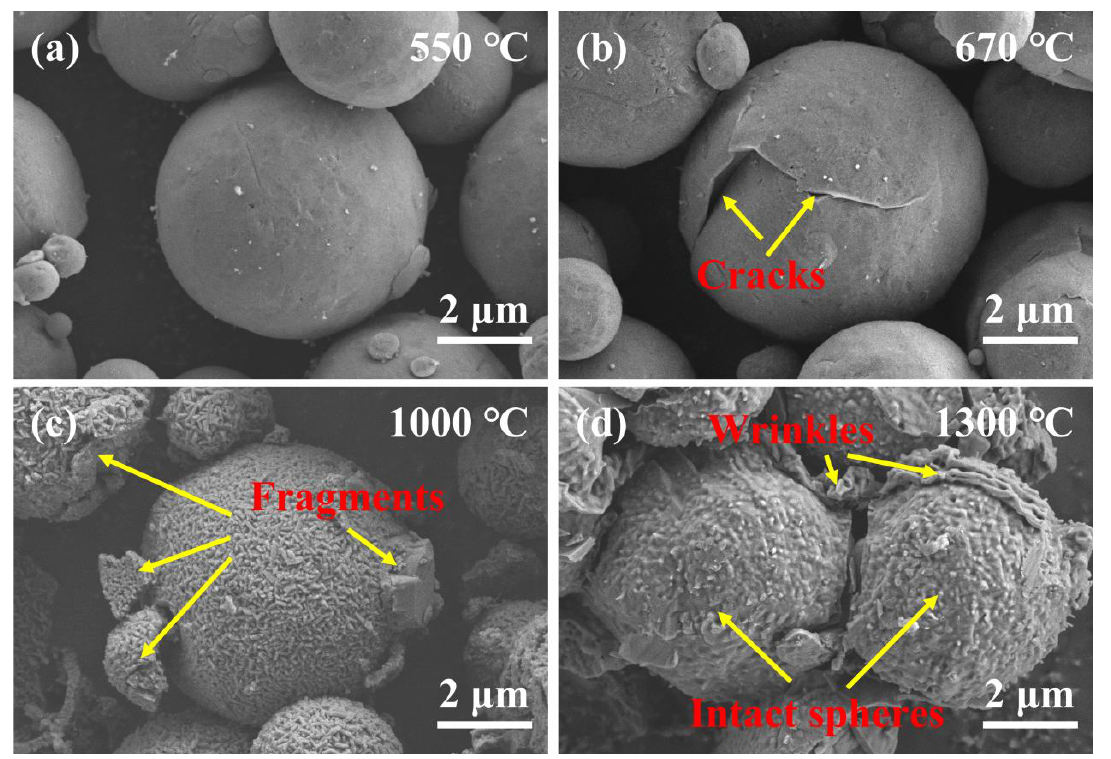
Figure 5. SEM images of oxidation products of Al powders at different temperatures. ( a ) 550 °C; ( b ) 670 °C; ( c ) 1000 °C; ( d ) 1300 °C. The products were recovered from TG-DSC analysis.